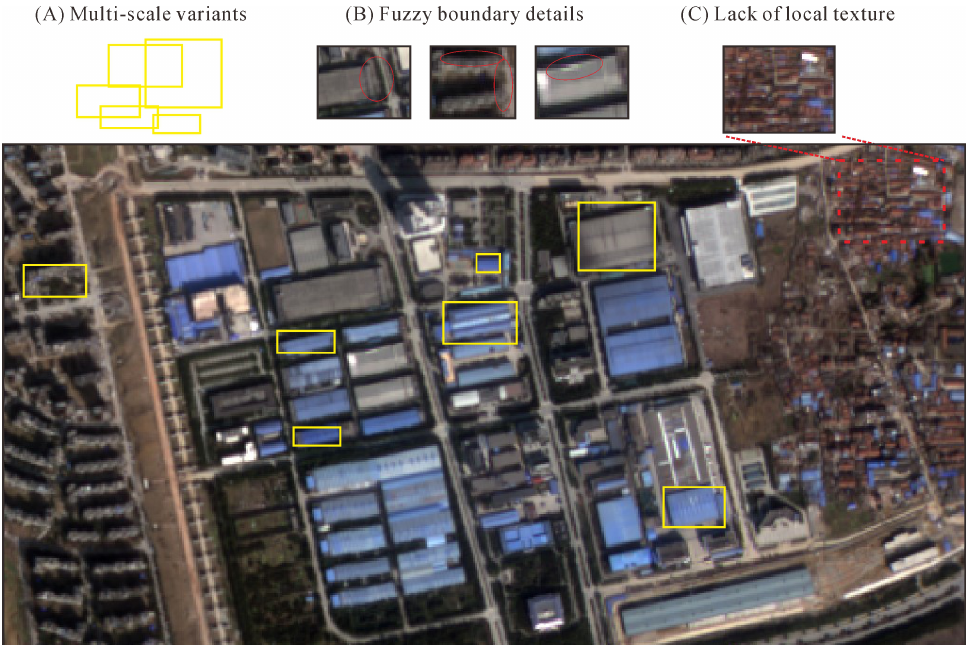
Figure 1. The main challenges of building segmentation in the LR remote-sensing imagery. ( A ) multi- scale variants. ( B ) fuzzy boundary details. ( C ) lack of local textures. The image was captured by the Gaofen-2 satellite with a resolution of 4 m/pixel. Red circles in subfigure ( B ) indicate the notable parts of the fuzzy